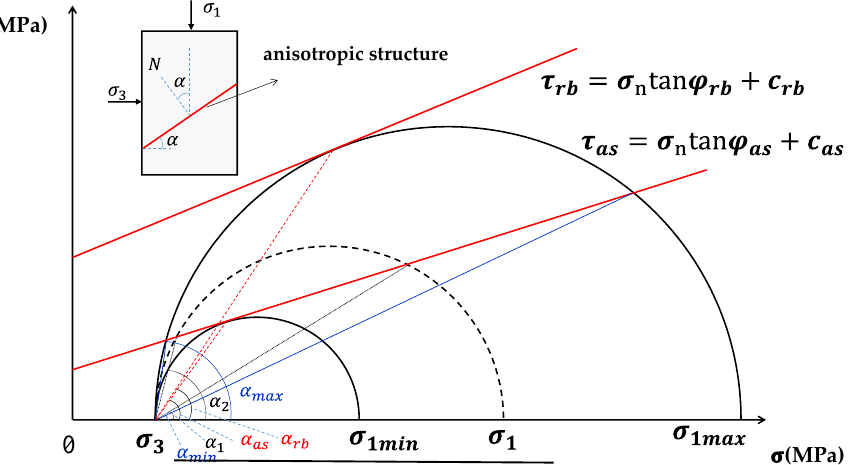
Figure 2. The Mohr circle analysis on limit failure condition of anisotropic rock mass. 𝜏 𝑟𝑏 and 𝜏 𝑎𝑠 denote the shear strength of rock block and anisotropic structural plane, respectively, while 𝜎 𝑛 denotes the normal stress on shear failure plane.